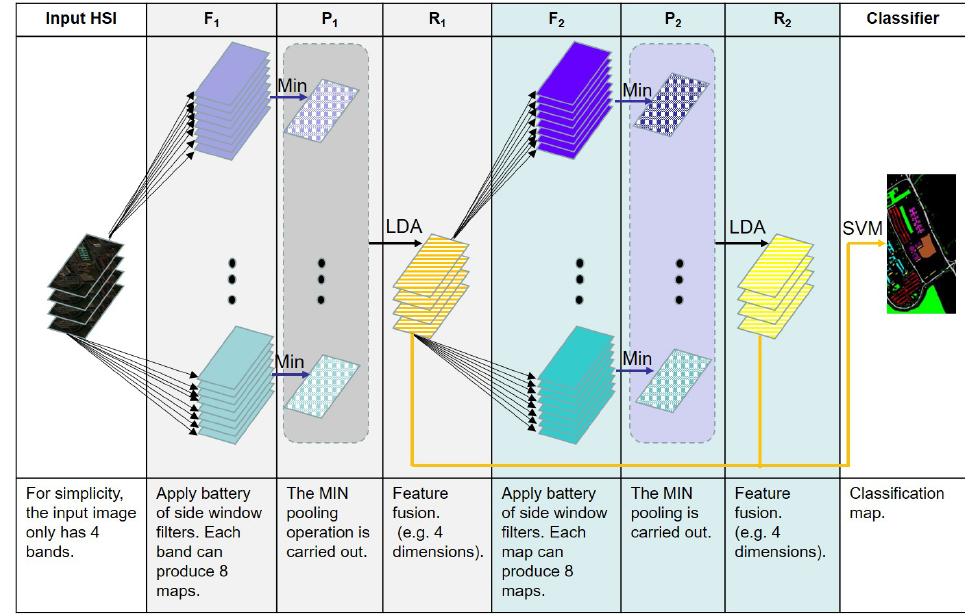
Figure 1. Schematic diagram of the proposed SANet, where only six hidden layers have been given for